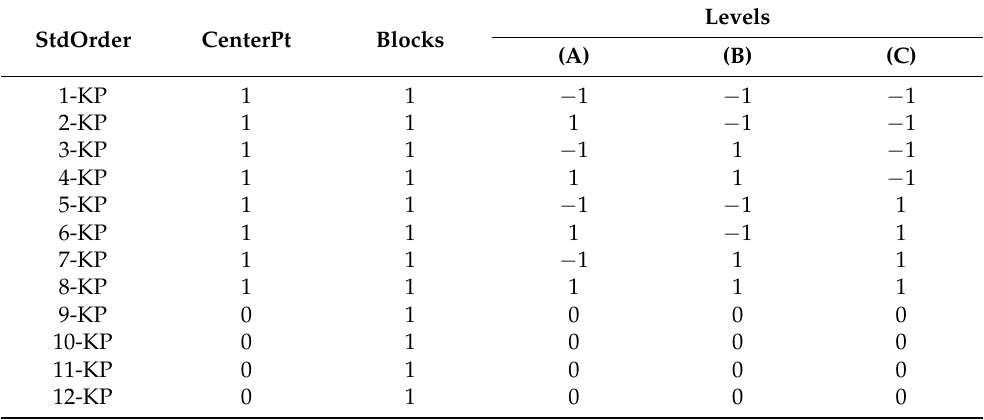
Table 2. Experimental design matrix. StdOrder CenterPt